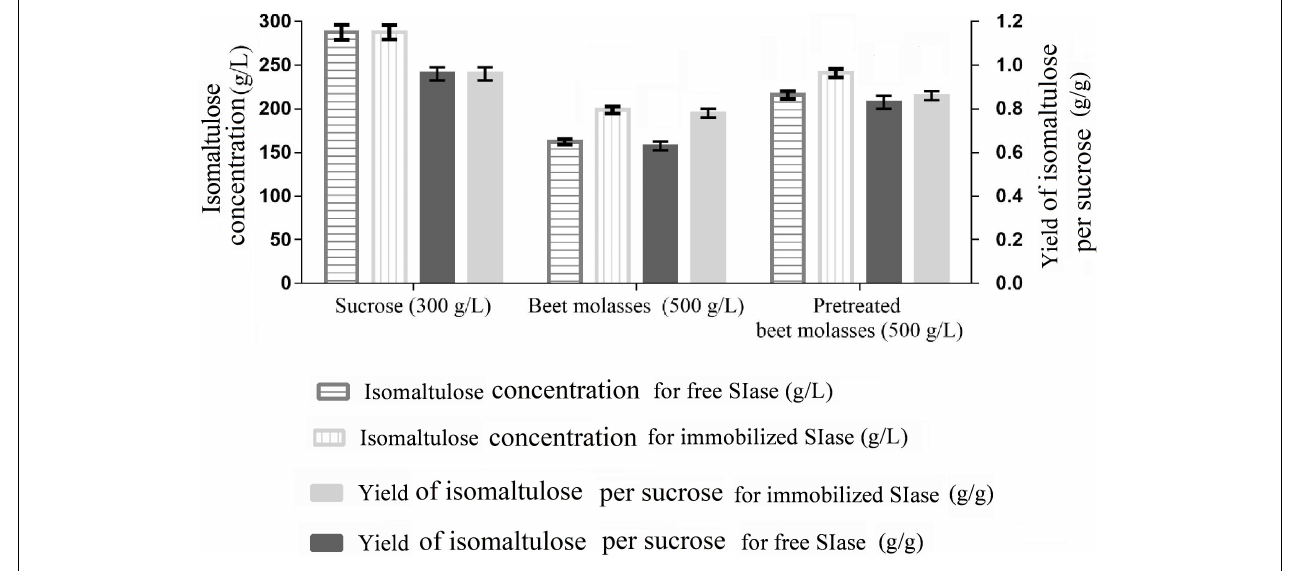
FIGURE 2 | Isomaltulose production from different substrates by free and immobilized sucrose isomerase (SIase) under the conditions of SIase dosage of 15 U/g, pH of 6, and temperature of 40 ◦ C.